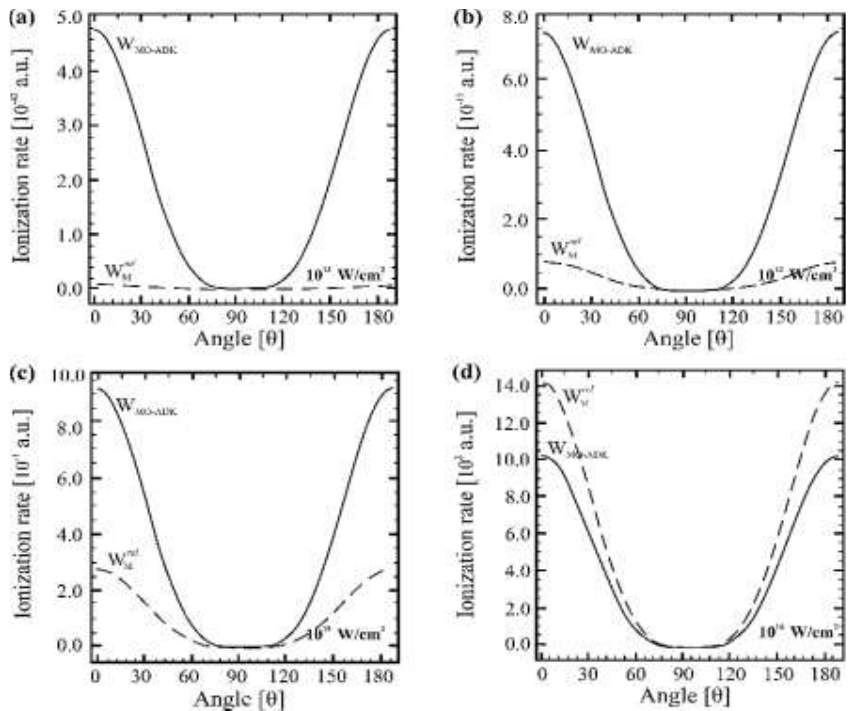
( 𝐹, 𝑅 ) 𝑀𝑂−𝐴𝐷𝐾 10 13 W 10 14 W 10 15 W , (b) 1 × , (c) 1 × , cm 2 cm 2 cm 2 10 16 W and (d) 1 × cm 2